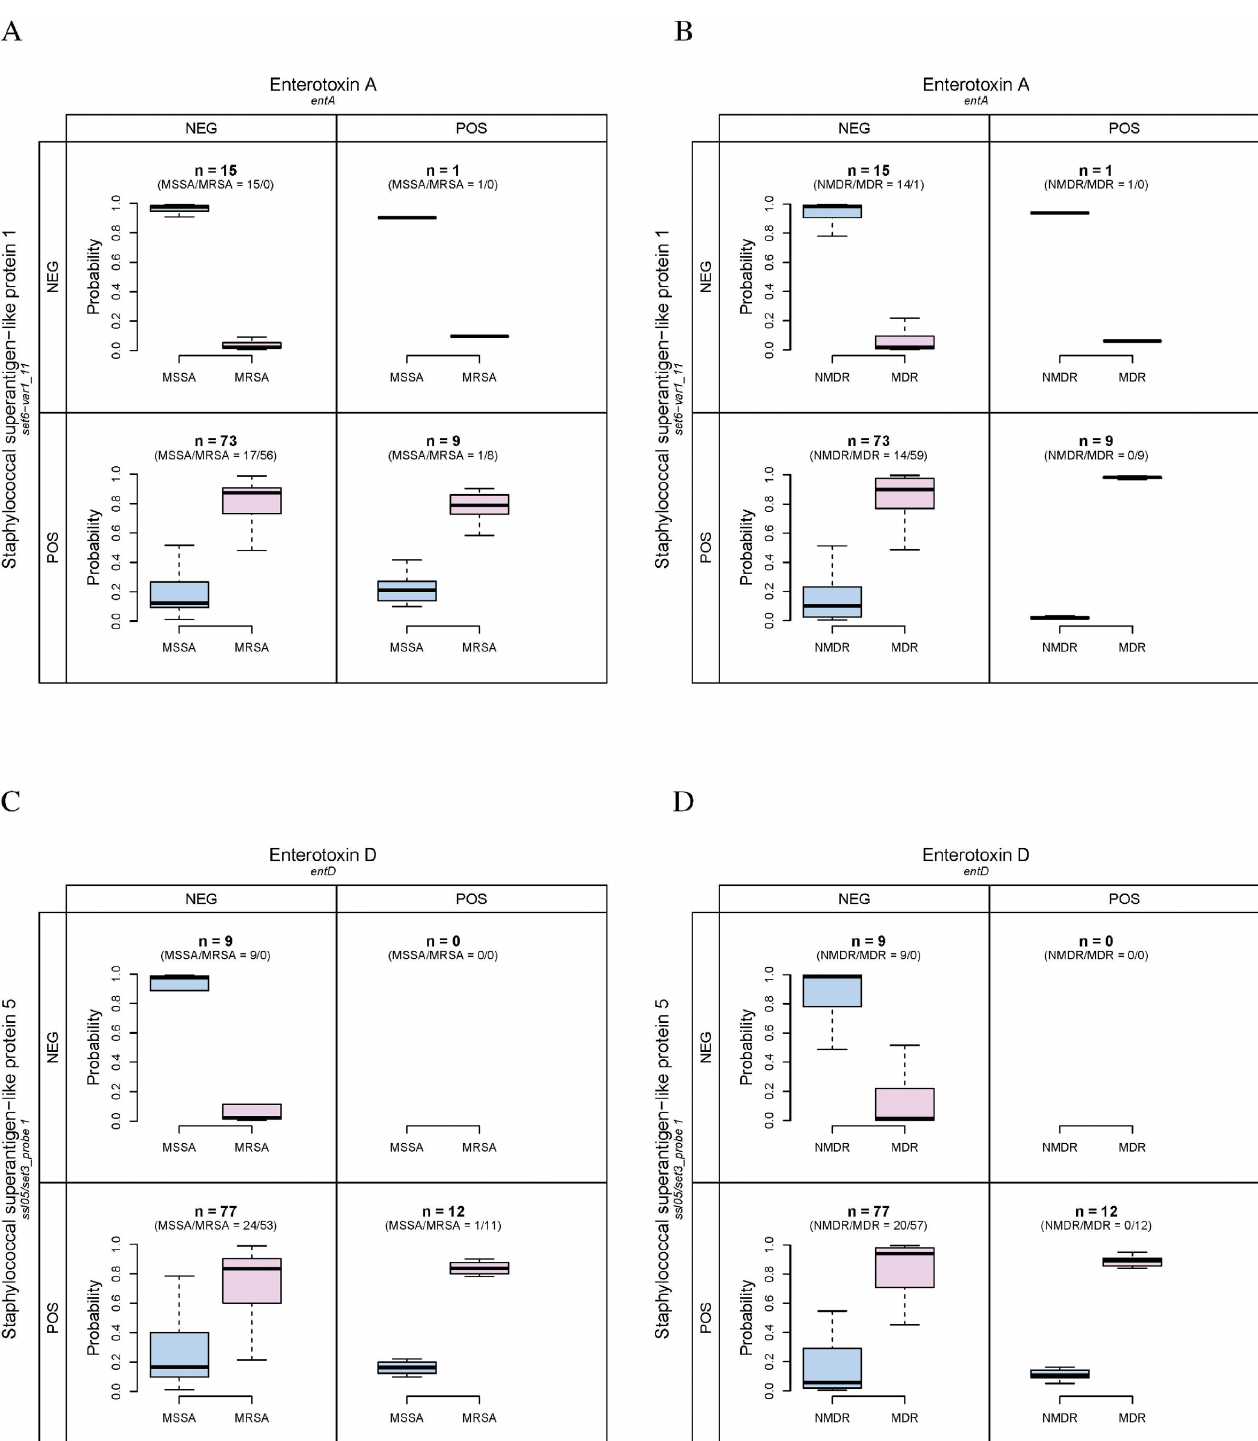
Fig 2. Interactions between staphylococcal enterotoxins A and D and superantigen-like proteins 1 and 5 for predicting the phenotypic expressions of MRSA and MDR S. aureus . The numbers of detected MSSA, MRSA, NMDR and MDR isolates are listed in the parentheses. A: The interaction between entA and set6-var1_11 for MRSA. B: The interaction between entA and set6-var1_11 for MDR S. aureus . C: The interaction between entD and ssl05/set3_probe 1 for MRSA. D: The interaction between entD and ssl05/set3_probe 1 for MDR S. aureus .